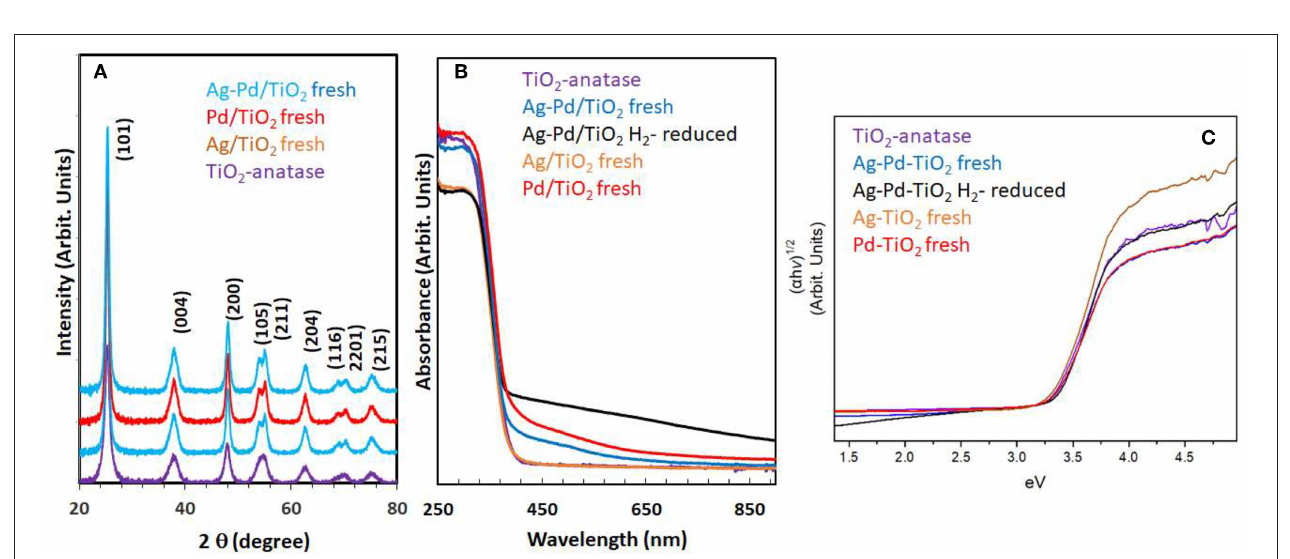
FIGURE 2 | (A) XRD of the TiO 2 (anatase), Ag/TiO 2 , Pd/TiO 2 , and Ag-Pd/TiO 2 ; (B) UV-Vis absorbance of TiO 2 , Ag-TiO 2 , Pd/TiO 2 , Ag-Pd-TiO 2 fresh, and H 2 -reduced; (C) The corresponding Tauc plots of the data of (B) .